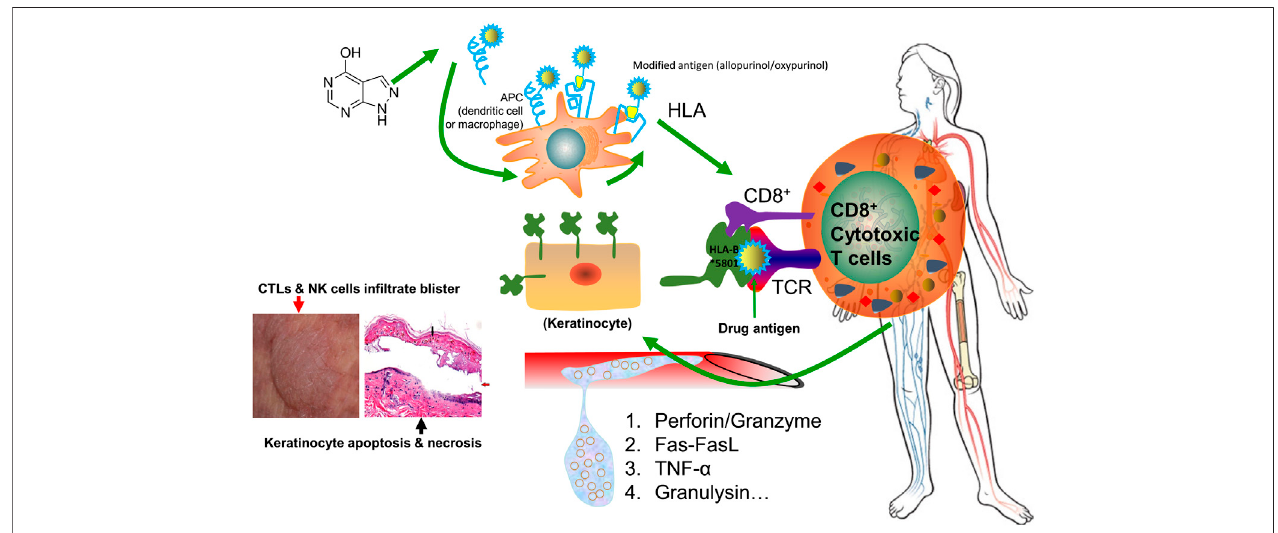
FIGURE 2 | Schematic representation of immunopathogenic mechanism underlying drug-induced SJS/TEN. The drug allopurinol is listed as the demonstrating drug. Allopurinol and/or its active metabolite oxypurinol is presented by antigen presenting cells (APC) and is interacting with HLA-B*58:01 protein. They are capable of generating a suf fi cient strong signal to TCR for cell activation. Upon activation, the stimulated CD8 + cytotoxic T cells will have a cascade release of cytokines or chemokines, including perforin/granzyme, Fas-FasL, TNF- α , and granulysin, which will kill keratinocytes and mucosal cells causing skin sloughing and necrosis. Meanwhile, CTLs and NK cells will in fi ltrate into the skin to form blisters. The left bottom image illustrates keratinocyte necrosis (black arrow) and development of large bullae (red arrow), adapted from (Gupta et al., 2019). Abbreviations: APC: antigen presenting cells. APCs include dendritic cells, macrophages, Langerhans cells, and B cells. TCR: T-cell receptor. CTLs: cytotoxic T lymphocytes. NK cells: natural killer